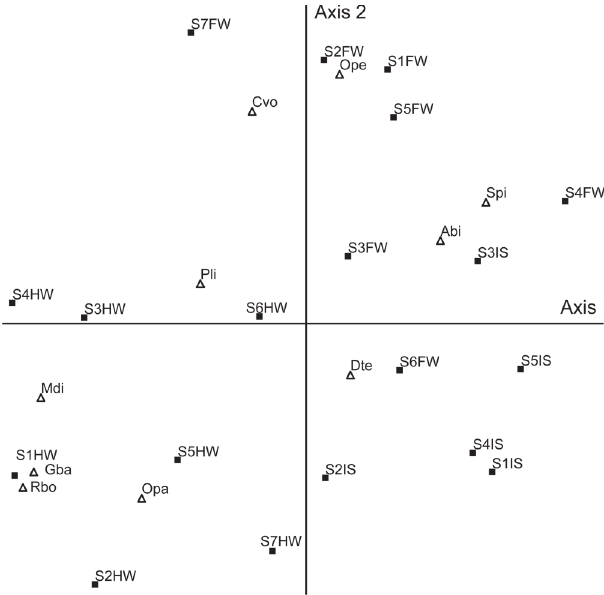
Fig. 4. NMDS ordination of dominant fish for different hy- drologic condition (HW = high water, FW receding water, IS isolation) and sites (S). Ope = Odontostilbe pequira , Cvo = Cyphocharax voga , Spi = Serrapinnus calliurus , Abi = Astyanax bimaculatus , Pli = Prochilodus lineatus , Mdi = Moenkhausia dichroura , Gba = Gymnogeophagus balzanii , Rbo = Roeboides microlepis , Opa = Odontostilbe paraguay- ensis , Dte = Diapoma